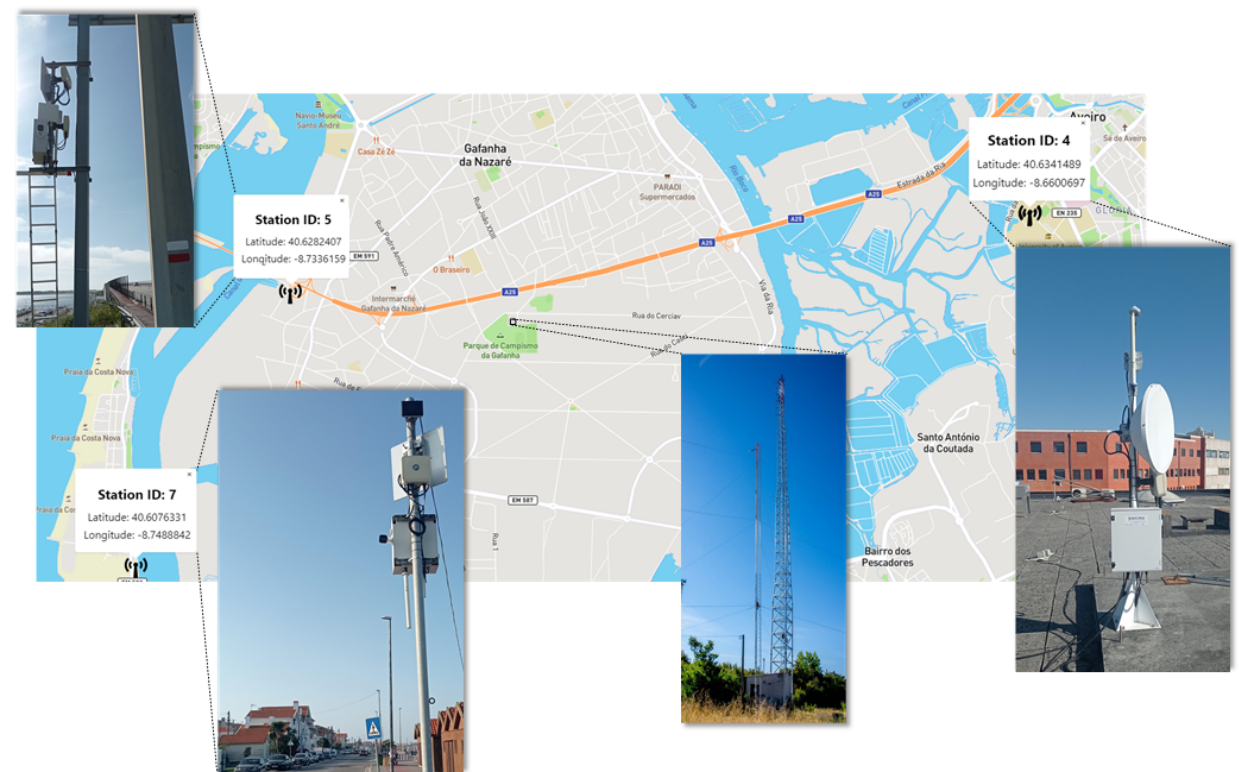
Figure 12. RSUs installed with a radio link connection.